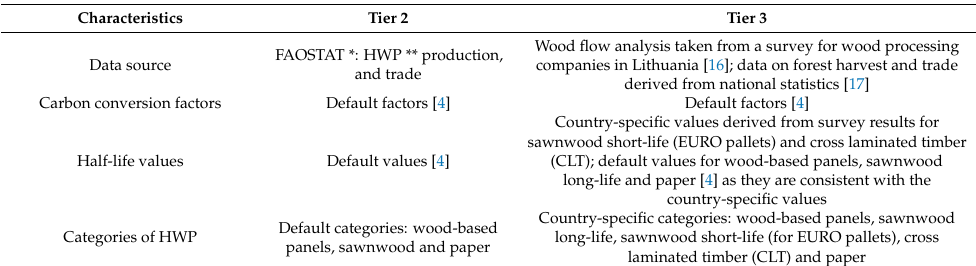
Table 1. Main characteristics of the Tier 2 and Tier 3 methods applied in this